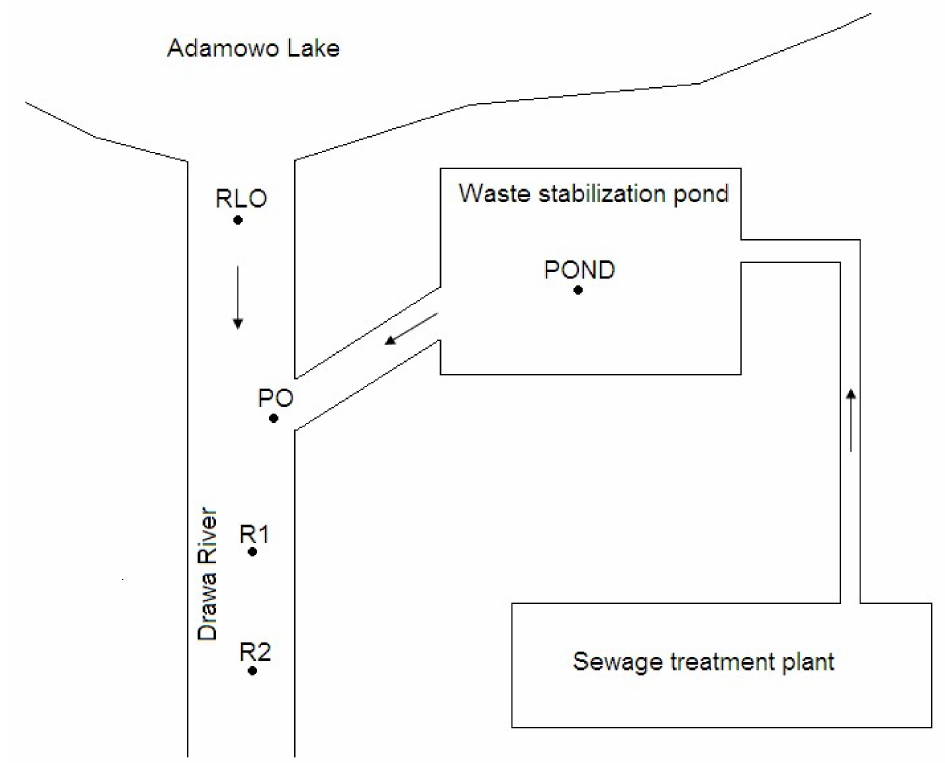
Figure 1. Scheme of the study area. RLO—river outflow from the lake; POND—waste stabilization pond of sewage treatment plant; PO—pond outflow; R1—site in the river, 20 m below the pond outflow; R2—site in the river, 40 m below the pond